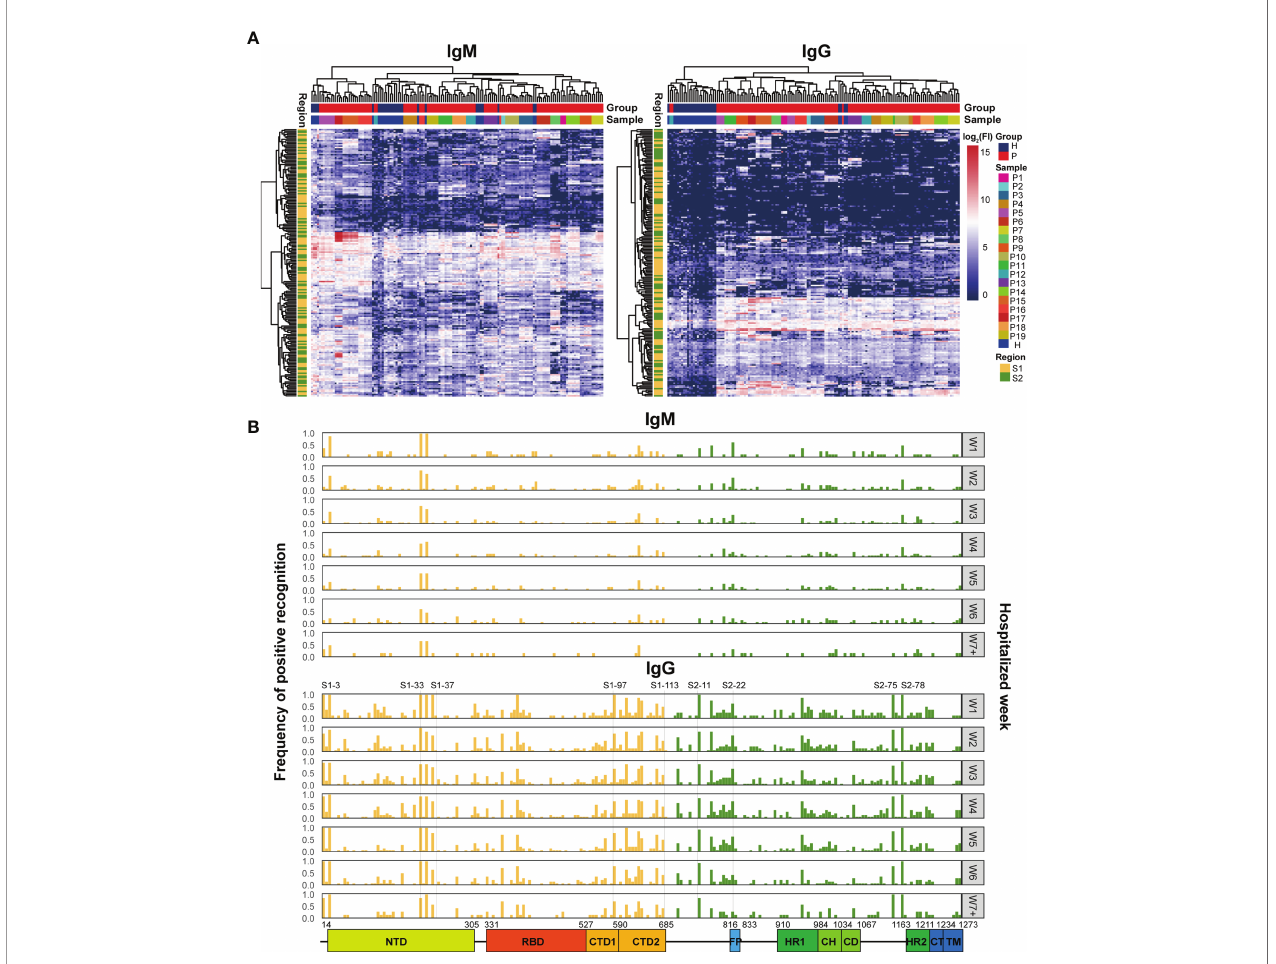
FIGURE 2 | Microarray analysis of the immune recognition features in the S peptide epitopes. (A) Hierarchical clustering of signals based on immune reactivity from IgM or IgG of healthy subjects and COVID-19 patients against all the S synthesized peptides measured by microarray. The bars upper: distribution of the healthy (blue) and COVID-19 (red) samples (top) and of all the individual samples (bottom) based on the clustered results. The bars right: the intensity indicator of immune reactivity (left) and the indicator of individual samples (right). The bar left indicates the distribution of S1 (yellow) and S2 (green) based on the cluster results. (B) Frequency distribution of the S peptides positively recognized by the patient IgM or IgG during hospitalization. The x axis represents the entire S gene sequence; the color bars at the bottom denote functional domains of S protein, namely, N-terminal domain (NTD, 14 – 305), receptor binding domain (RBD, 331 – 527), C-terminal domain 1 (CTD1, 528 – 590), C-terminal domain 2 (CTD2, 591 – 684), fusion peptide (FP, 816 – 83), heptad repeat 1 (HR1, 910 – 984), central helix (CH, 985 – 1034), connector domain (CD, 1,035 – 1,067), HR2 (heptad repeat 2, 1,163 – 1,211), transmembrane domain (TM, 1,212 – 1,234), and cytoplasmic tail (CT, 1,235 – 1,273).The y axis (left) represents the frequency of the S peptides that are positively recognized by antibodies, while the gray signs on right mean the hospitalization time (weekly counted). The yellow and green bars indicate S peptides located in the S1 and S2 subunits,